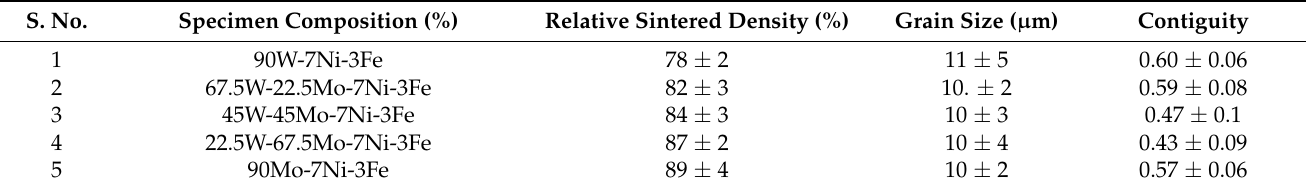
Figure 4. SEM (BSE mode) micrographs of alloys with the increase in molybdenum concentration. Table 3. Relative sintered density, grain size, and contiguity of all sintered heavy